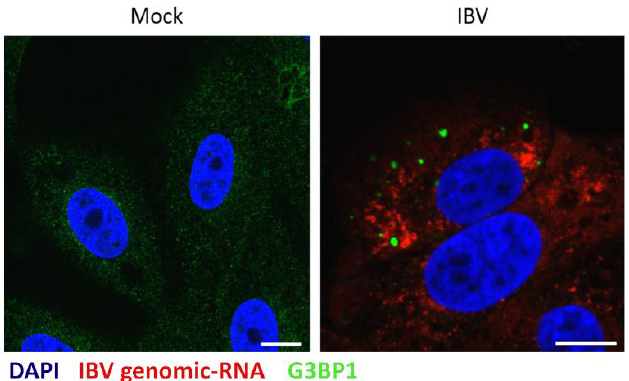
Figure 5. IBV genomic RNA is not diverted to stress granules during infection. Vero cells were mock infected or infected with IBV for 24 hours. IBV genomic RNA (red) was detected using Fluorescent in situ Hybridization (FISH) probes and an anti-G3BP1 antibody was used to detect SG (green). Nuclei were stained using DAPI (blue). Scale bars indicate 10 µm. Images are representative of three independent replicates.